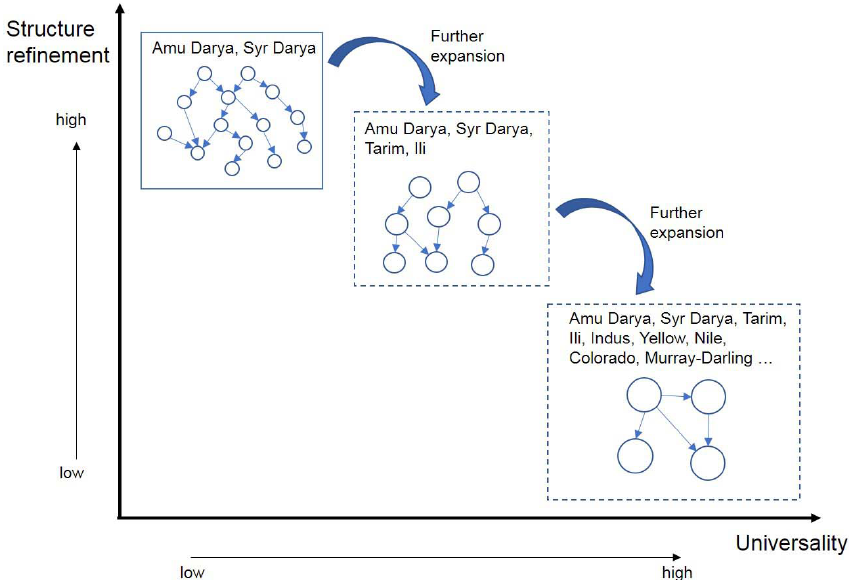
Figure 10. The trade-off of structure refinement and universality in the new framework for comparing the basin-wide water–energy–food– ecology nexus based on the adjustable causal